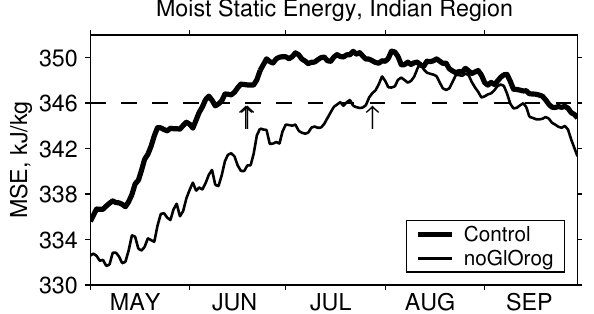
Fig. 4. Surface Moist Static Energy (SMSE) over the Indian region from the control and noGlOrog simulations. The onset dates obtained from the precipitation criteria are marked by arrows against each time series. Note that SMSE crosses the threshold of 346kJkg − 1 over this region a few days before the onset of precipi- tation in the respective simulations.